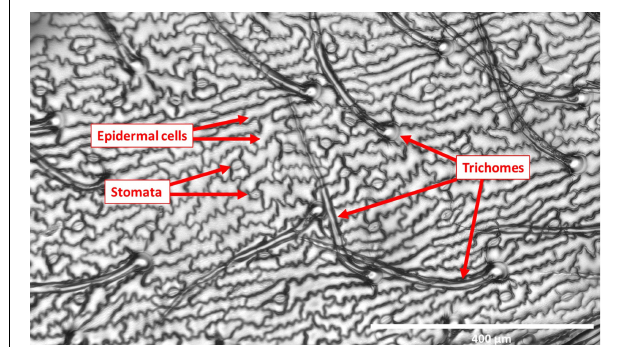
FIGURE 1 | Representative image of a leaflet imprint at 10X magnification used to quantify micromorphological traits on the surface. Scale bar in image = 400 µ